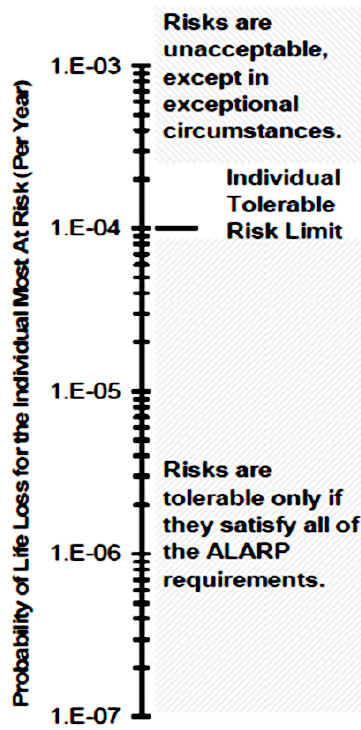
Figure 9. Proposed individual risk thresholds according to the up- dated USACE guidelines for levee safety (USACE,